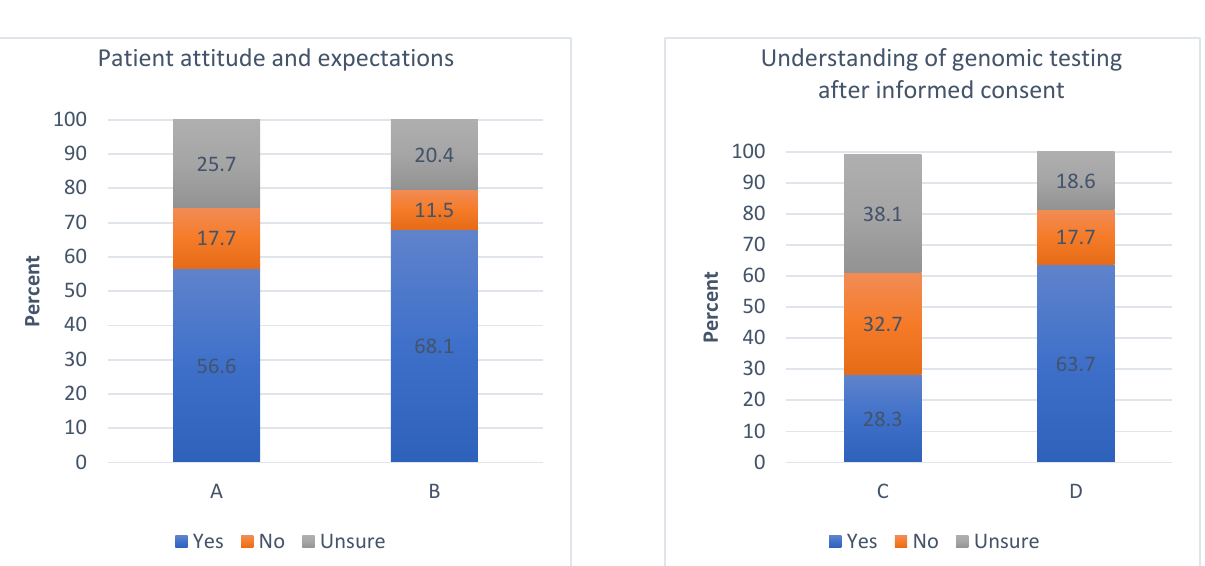
Figure 1. Patient survey responses regarding general knowledge of cancer and its testing. ( a ) A. Cancer represents uncontrolled cell growth; B. Genomics testing can be used to help predict how long a patient might live with cancer; C. Genomics testing can be used to help predict a patient’s response to a specific cancer drug. ( b ) Genomics testing (for acquired and inherited mutations) can potentially be used for which of the following: A. To confirm the type of cancer diagnosis, B. To predict the risk of cancer for an individual and their children or relatives, C. To select treatment and monitor a patient’s response to therapy, D. To predict disease outcome, E. All of the above.